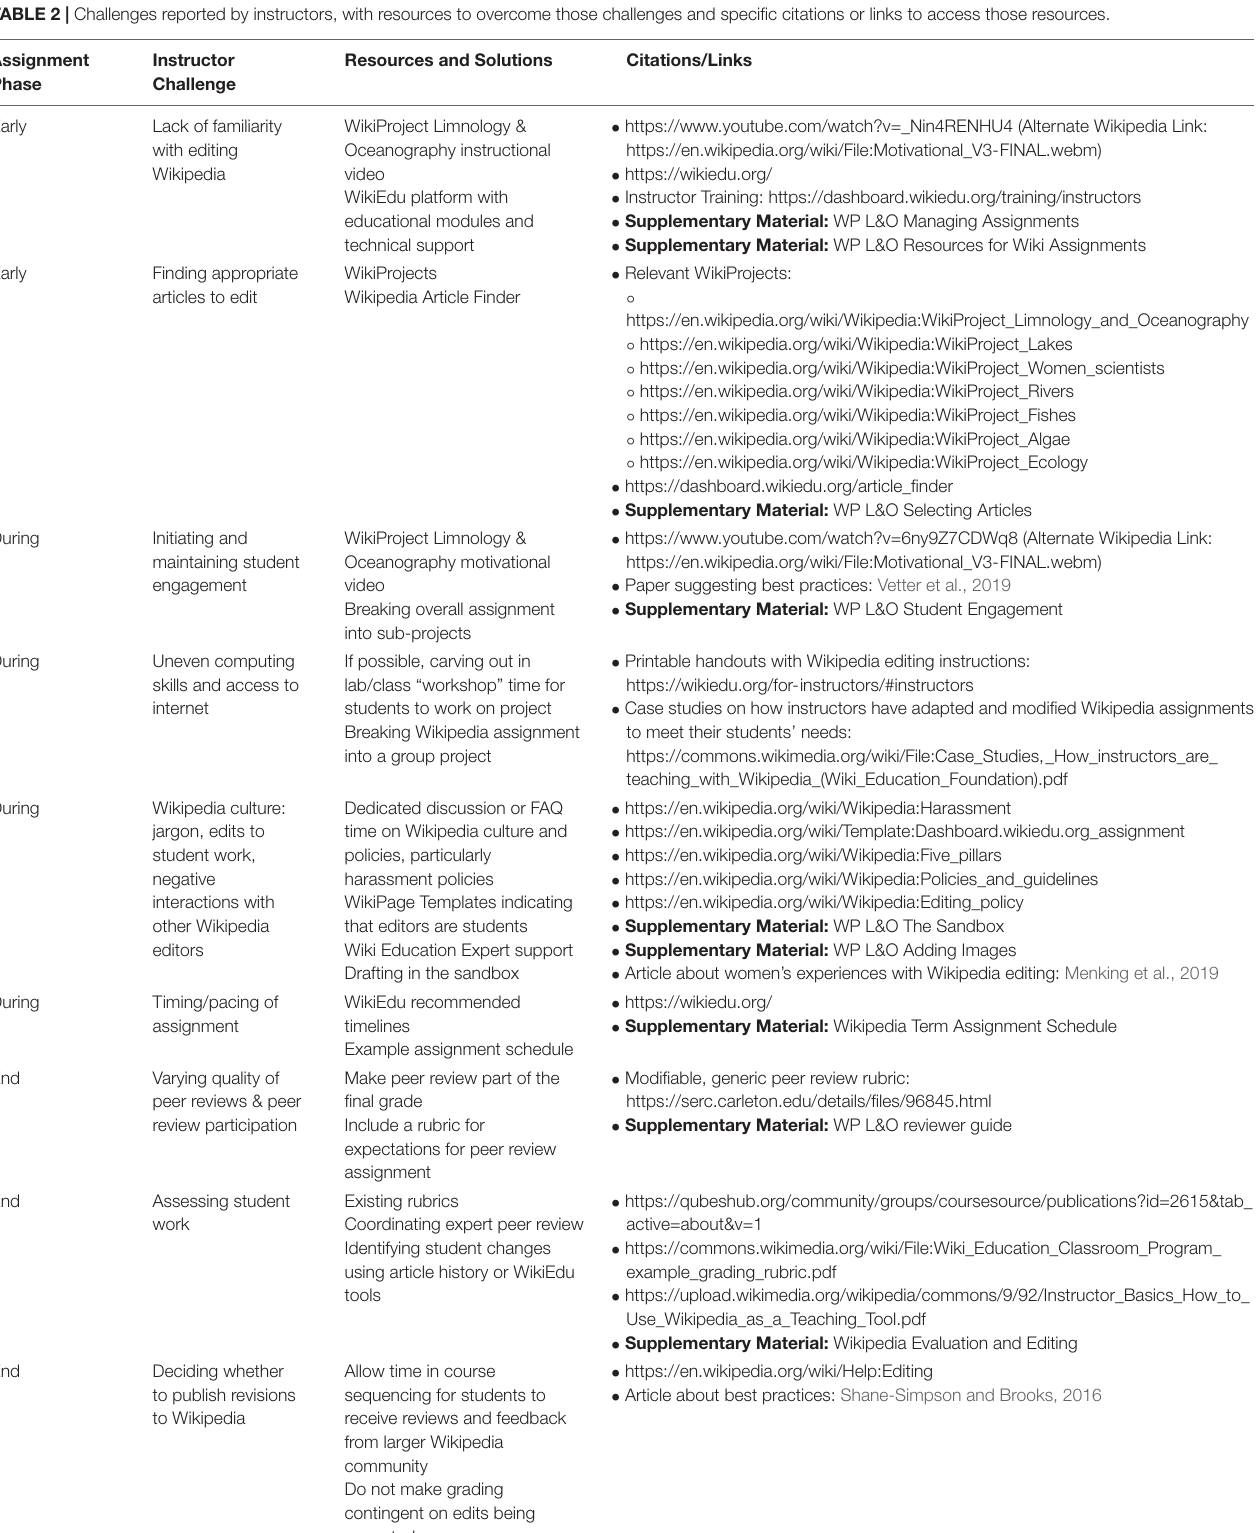
TABLE 2 | Challenges reported by instructors, with resources to overcome those challenges and specific citations or links to access those resources. Assignment